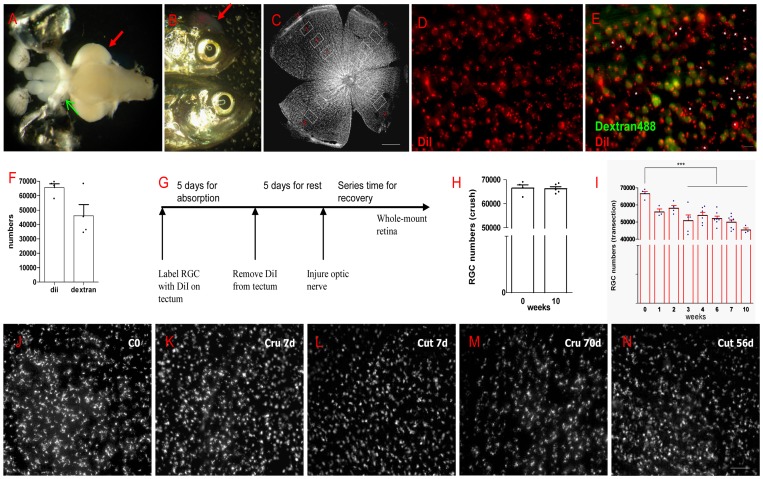
Most RGCs survived after ONI.(A) Two methods were used to label RGCs, the red arrow indicates DiI placed on tectum, the green arrow indicates Dextran 488 at optic nerve stump. (B) The red arrow shows lightcuring bond on the skull to prevent DiI lost. (C) The sampling of RGCs counting in the entire retina. (D) An example of DiI labeled RGCs. (E) Merge DiI and Dextran labeled RGCs in the same field. Asterisks indicate cells labeled by DiI but not by Dextran488. (F) Though the number of labeled cells has no significant difference (p>0.05) between DiI and Dextran, retrograde labeling with DiI is more reliable. (G) A scheme of DiI labeling in RGC survival experiment. (H) Almost all RGCs survived in ONC model after 10 weeks. (I) Significant RGCs lost began at 3 weeks (about 20% lost) but over 70% of RGCs were still alive at 10 weeks after ONT, p<0.001. (J-N) Representative pictures show RGCs at different time in ONC or ONT model. * indicates p<0.05, *** is p<0.001. Scale bar: 200 µm (C); 10 µm (E); 30 µm (J-N).